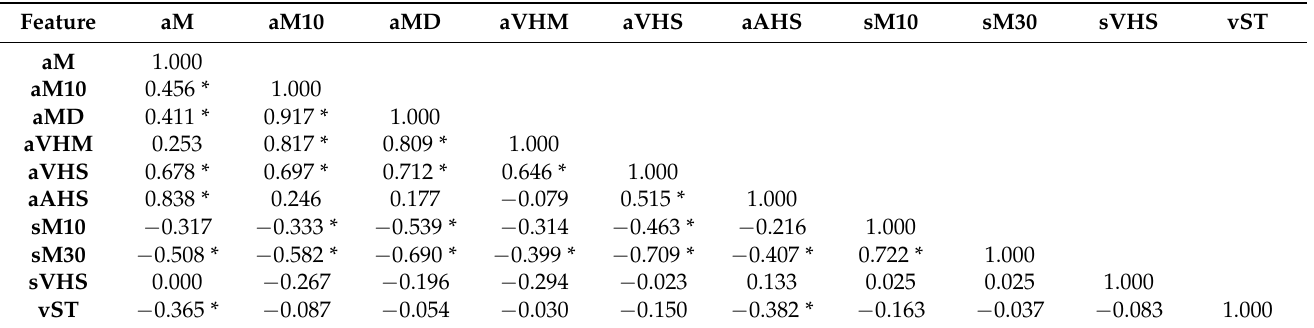
Table 4. Correlation matrix of the top 10 features for the pelvis (* p -value <